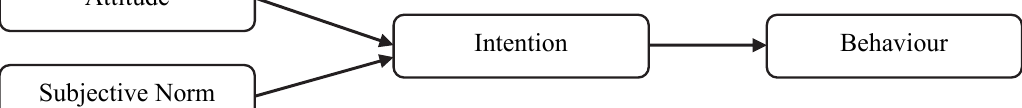
Fig. 1. Theory of reasoned action (TRA) Source: Ajzen and Fishbein (1980)